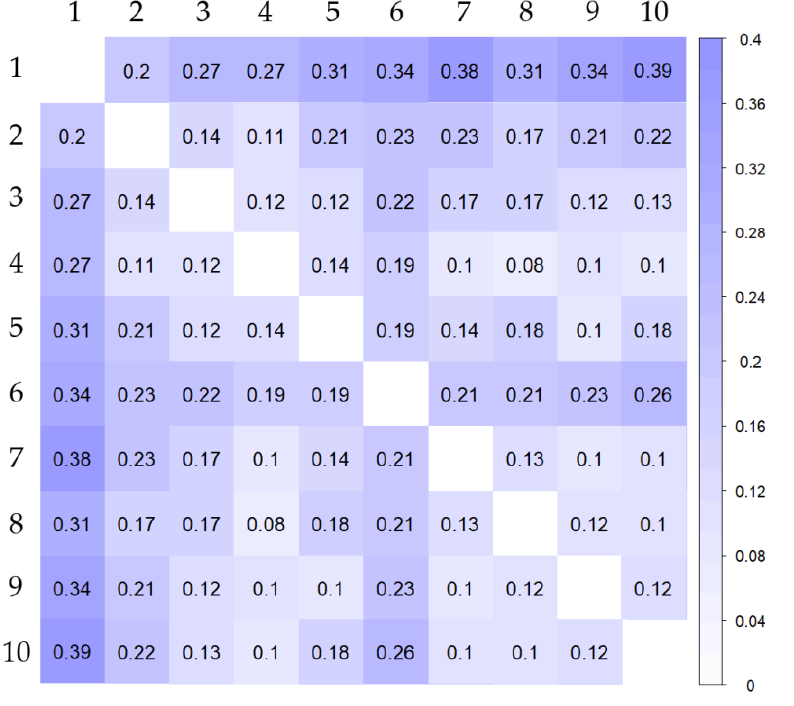
Figure S2: Graph of BIC values shows the optimum number of clusters (k = 10). Table S1: Genotypes of 201 diploid apricot accessions and one interspecific hybrid (aprium) revealed by 10 microsatellite markers. Table S2: Genetic parameters of apricot landraces and cultivars released from breeding programs (commercial and recent) for the 10 studied microsatellite loci. Table S3: Pairwise F